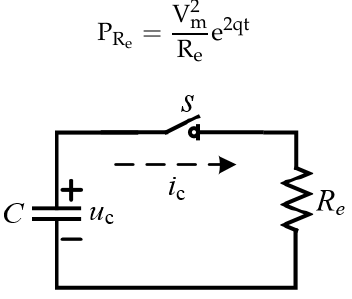
C; (b) the relationship between i Lm and C; (c) the relationship between t m and C.